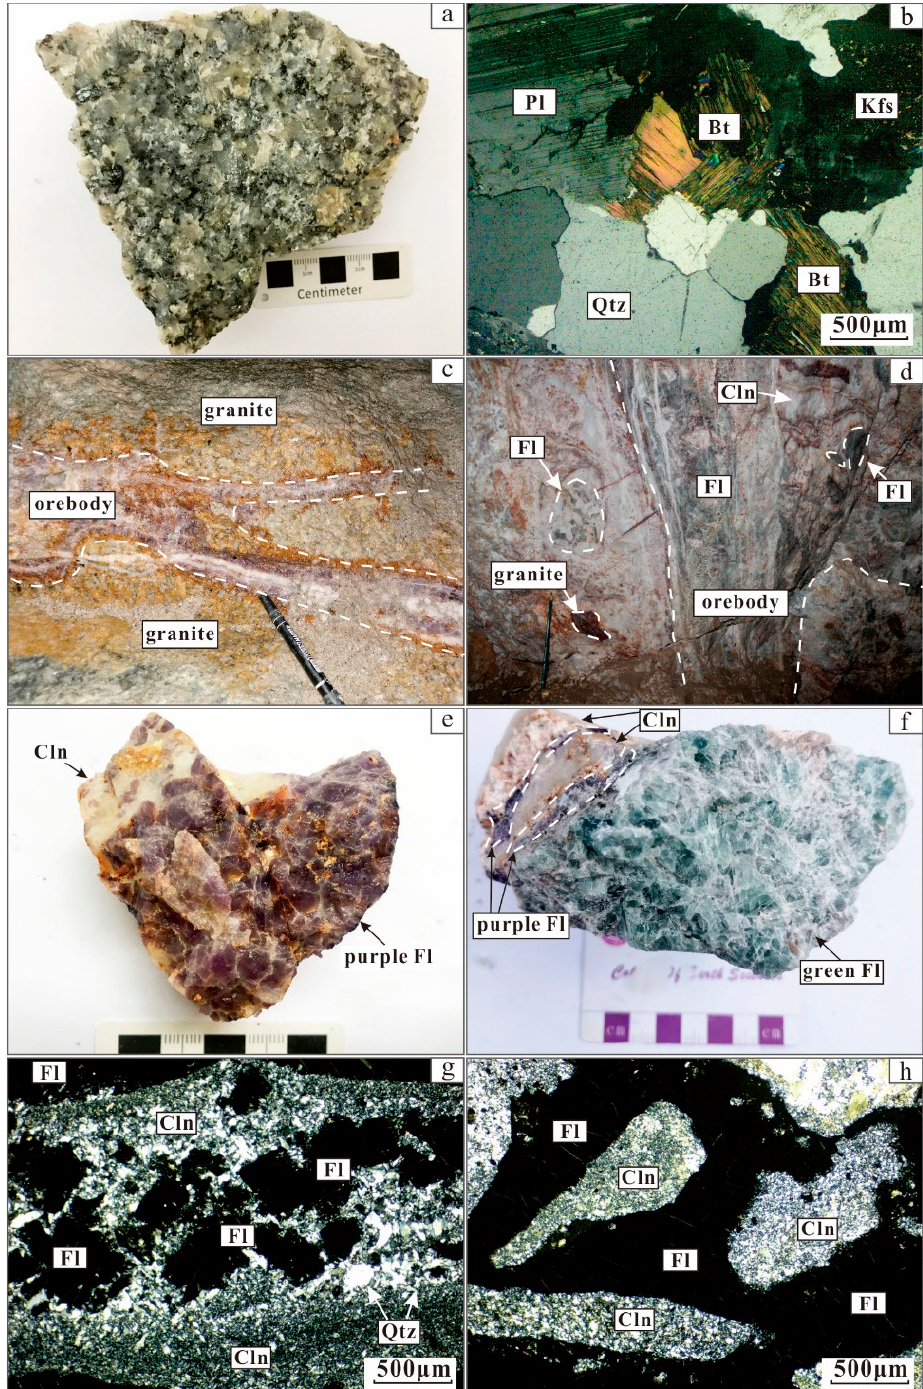
Figure 3. Photographs of orebodies and hand specimens: ( a ) hand specimen of the Xiangcaoping granite; ( b ) photomicrograph of the Xiangcaoping granite (cross polarizing light); ( c ) a fluorite orebody; ( d ) granite and fluorite fragments in fluorite orebody; ( e ) massive purple fluorite; ( f ) massive green fluorite; ( g ) photomicrograph of chalcedony veins containing fluorite crystal fragments (cross polarizing light); ( h ) photomicrograph of chalcedony fragments are cemented by fluorite (cross polarizing light). Qtz—quartz, Pl—plagioclase, Kfs—K-feldspar, Bt—biotite,